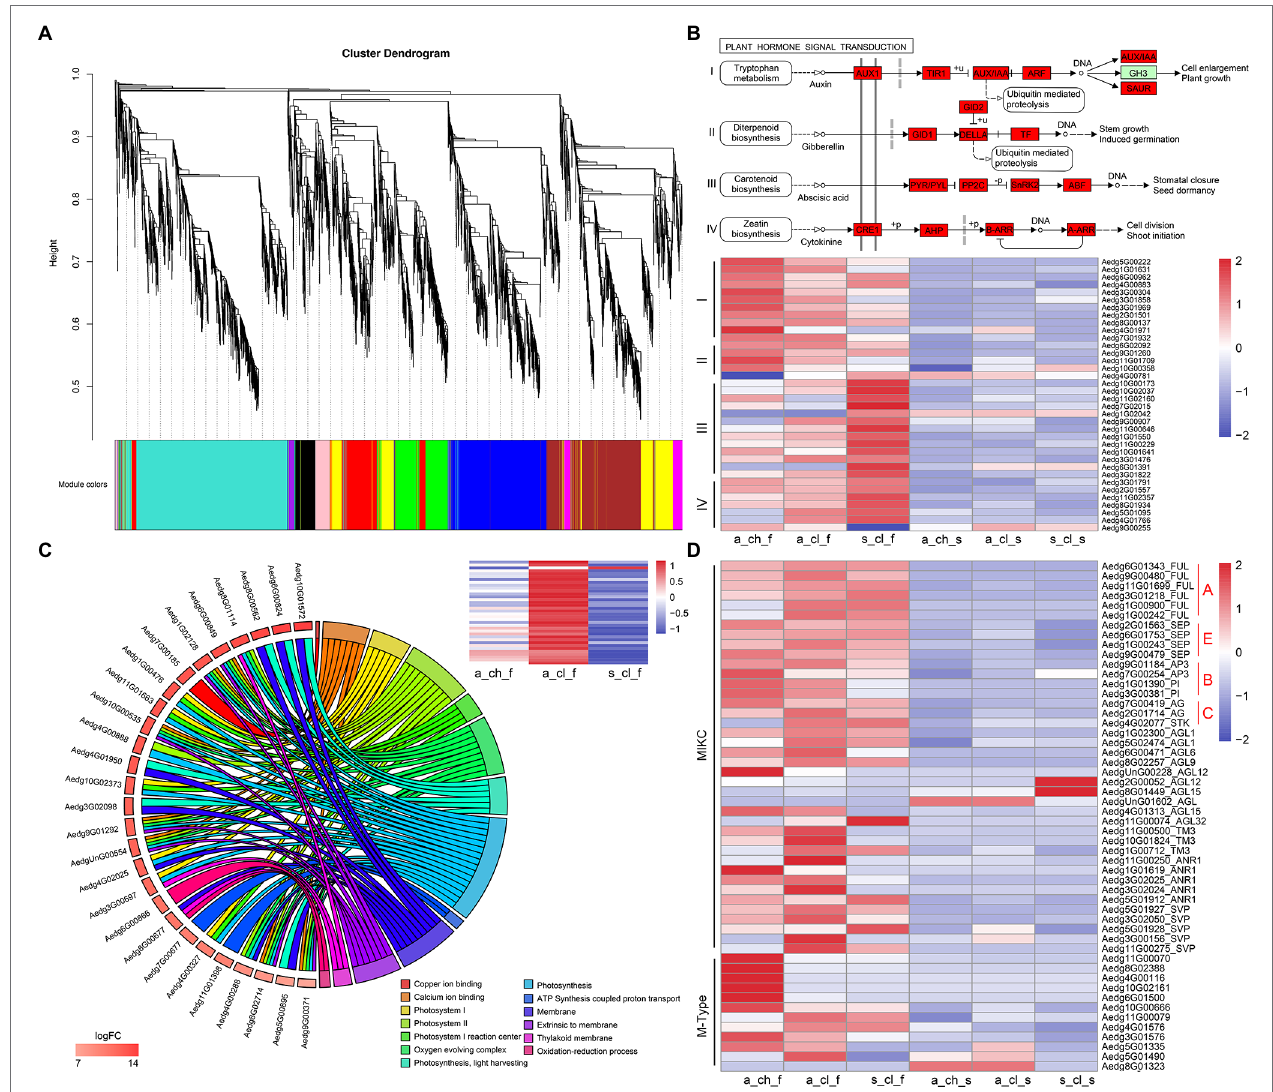
FIGURE 5 | Gene co-expression modules and clusters related to flower development. (A) Hierarchical cluster tree showing co-expression modules identified using WGCNA. (B) Hormone-enriched expression in MEyellow and MEturquoise. Red boxes indicate the genes that were identified. The heatmap shows the relative FPKM of genes from the module. (C) The chord plot of GO terms revealing enrichment to photosynthesis pathway genes. The heatmap shows the relative FPKM of genes from photosynthesis in the 3 types of flower. (D) Expression profiling of MADS-box from various organs of A. edgeworthii . Two genes clusters were divided according to the type of MADS-box genes. All expression values were scaled by log 2 (FPKM+1), where FPKM denotes fragments per kilobase of exon per million mapped